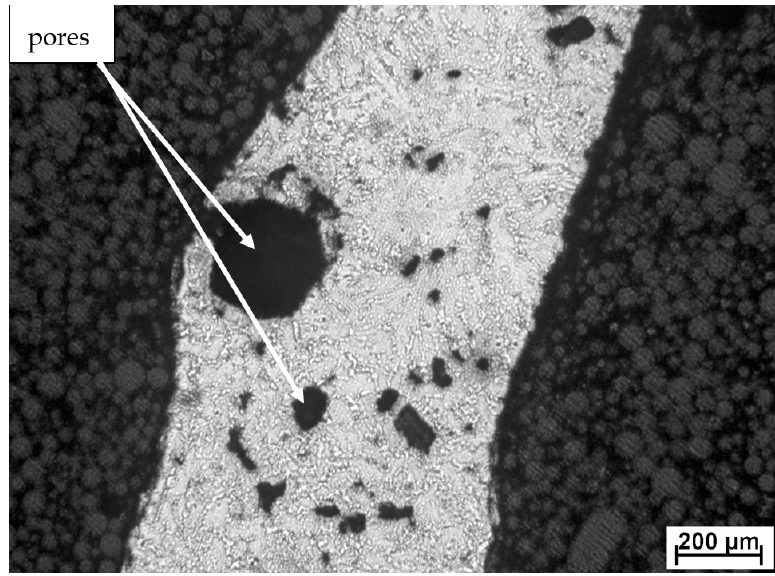
Figure 2. Microstructure of TiAl10Si30 after reactive